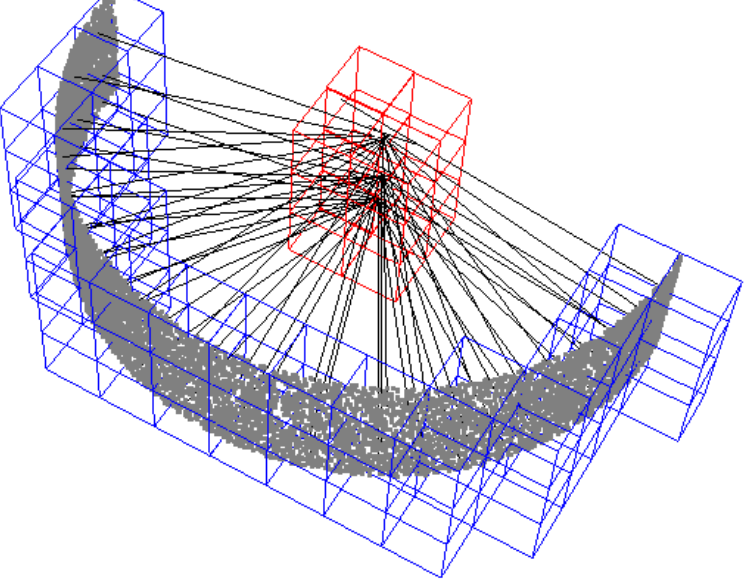
Figure 4. Synthetic data points of a semi-cylinder of height 7 cm and radius 15 cm. The blue voxels, containing cylinder surface points, are connected to the cylinder center voxels in red. All cylinder surface points that are connected to the cylinder center cluster in red are used in the estimate of the stem diameter. The data points in this example are filtered with a cluster weight of 15 and a curve weight of 0.75. The grid cell size is 3 × 3 × 3 cm 3